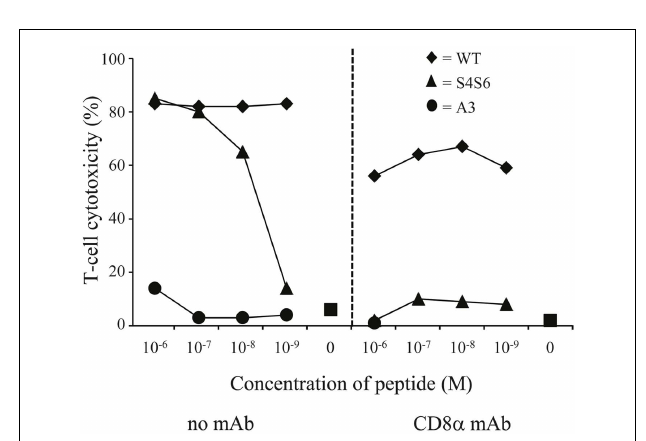
FIGURE 7 |The gp100APL S4S6 renders the gp100/HLA-A2-specificTCR CD8 dependent .TCR-engineeredT cells were tested in a 51 Cr-release assay as described in legend to Figure 3 either without or with blocking anti-CD8 mAb (left and right panels, respectively).T2 cells were either non-loaded or loaded with titrated amounts of gp100 wt peptide (wt) or APLs A3 and S4S6 (range: 10 − 6 –10 − 9 M peptide). Results of one (out of two) representative experiment are shown based on the mean value of triplicate data